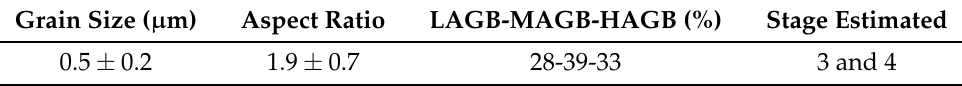
Table 5. Evaluation of microstructural indicators for the EBSD map at room temperature.